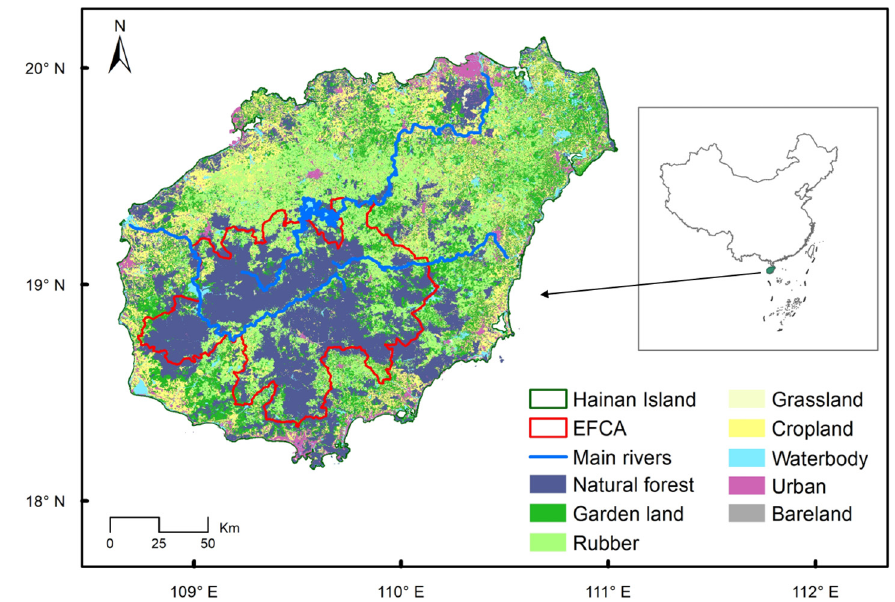
Figure 1. Land-use / land-cover map of Hainan Island in Figure 1. Land-use/land-cover map of Hainan Island in 2017.